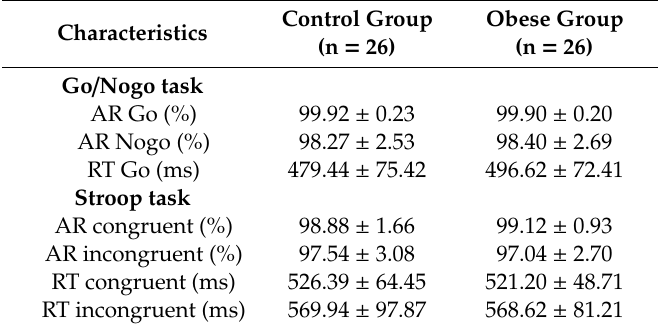
Table 2. Behavioral performance of the normal-weight (control) and obese